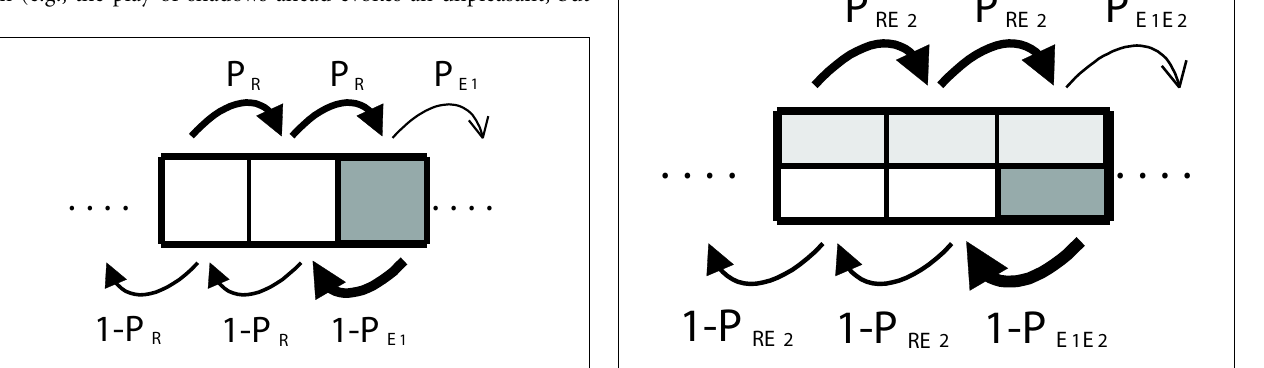
FIGURE 6 | Somatic marker system. The use of somatic markers (50% of the time in average) is represented by light gray areas that take up the half of the